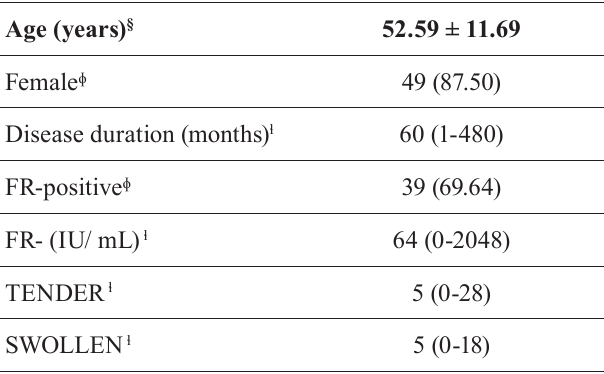
TABLE II - Characteristics of the patients (n = 56